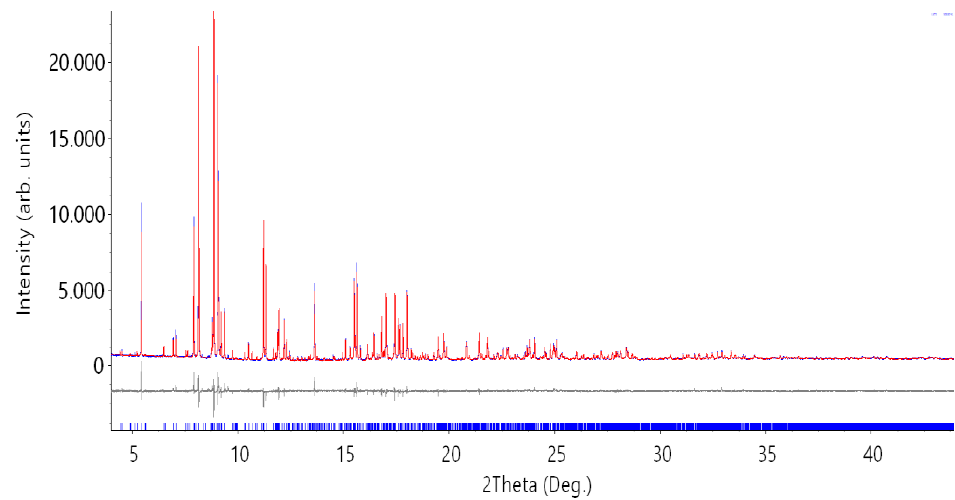
Figure 3. The final Rietveld diagram of La 0.987 Ti 1.627 Nb 3.307 O 13 on the synchrotron diffraction pattern. The measured (blue) and calculated (red) lines are superimposed, while the gray line below represents the difference. Vertical bars at the bottom mark the reflection positions.